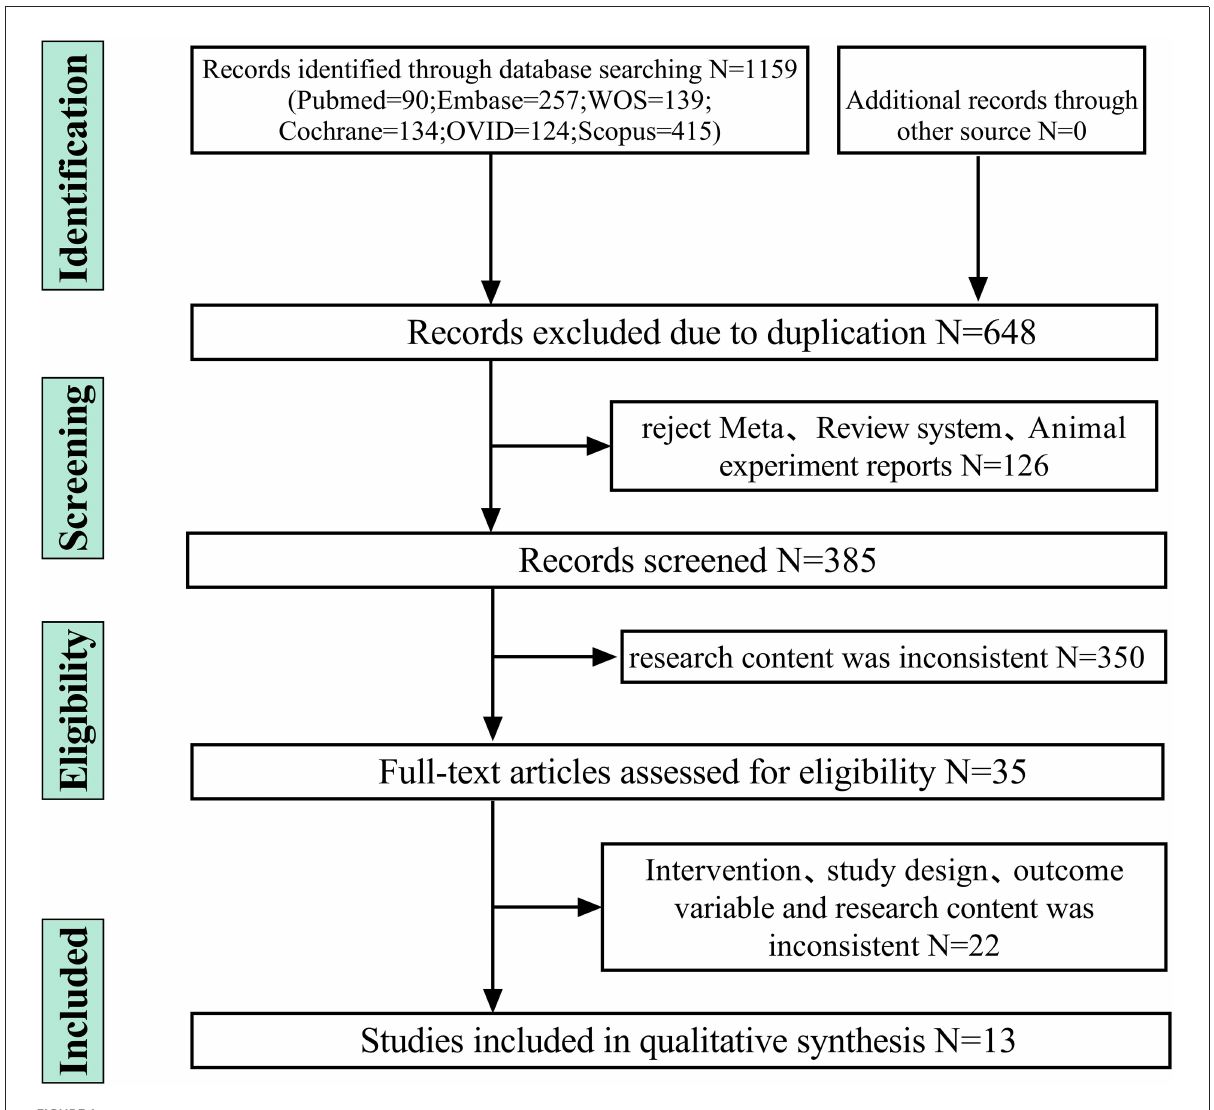
FIGURE1 Identification and screenning strategy of final included and excluded